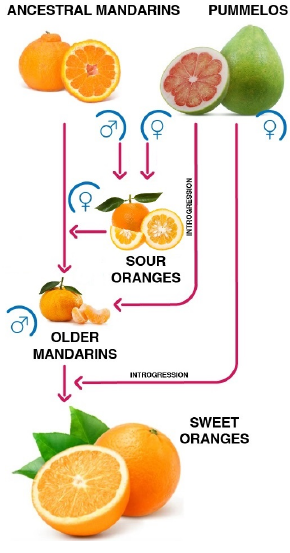
Figure 1. Sweet orange phylogeny[ male, female, red arrow: phylogenetic relationship]. 2. A Single Hybrid Ancestor, Different Fruit Typologies Despite the sweet orange being derived from a single unknown ancestor, the currently known sweet orange varieties show a wide variability in terms of fruit characteristics (Figure 2), especially those of color, taste, yield, maturity date (Figure 3), and many other horticulturally important traits. Such a wide variability is the result of the subsequent field selection, propagation, and diffusion of selected varieties in different cultivation areas throughout the years.